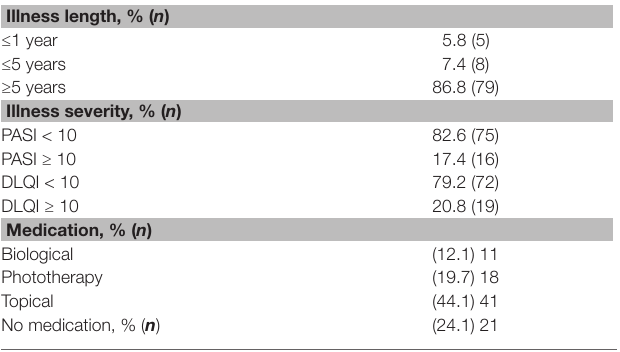
TABLE 1 | Disease characteristics in psoriasis group: illness length, illness severity, and type of medication. Illness length, % ( n ) ≤1 year